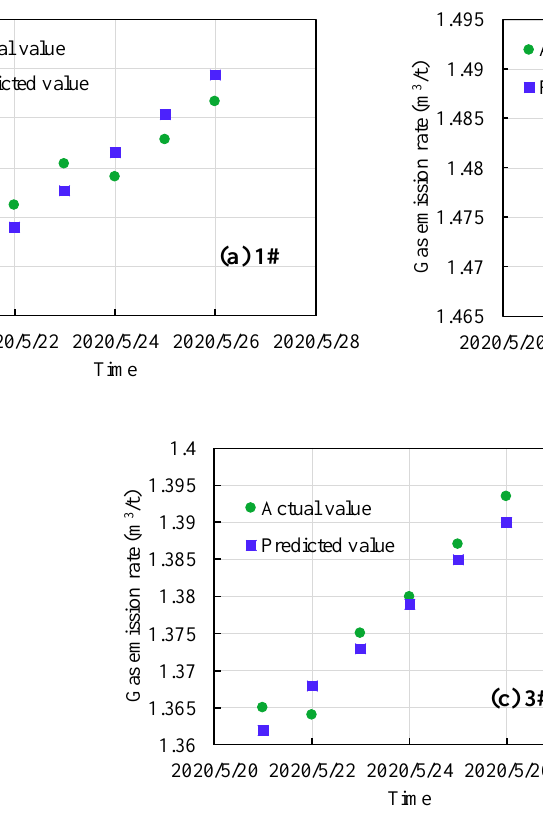
Table 4. Relative error between grey prediction result and measured